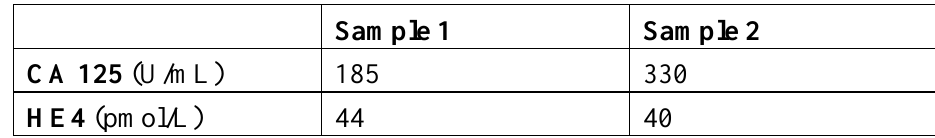
Table 1. CA125 (expressed as U/mL) and HE4 (expressed as pmol/L) levels, evaluated at a two different times (the first at the moment of the gynecologic examination and the second two weeks